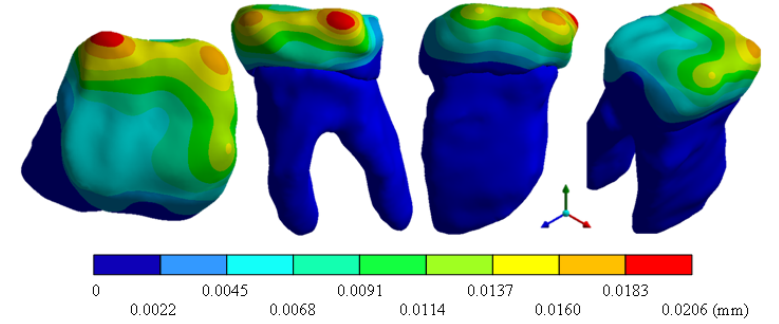
Figure 9. Total general displacement of the molar.